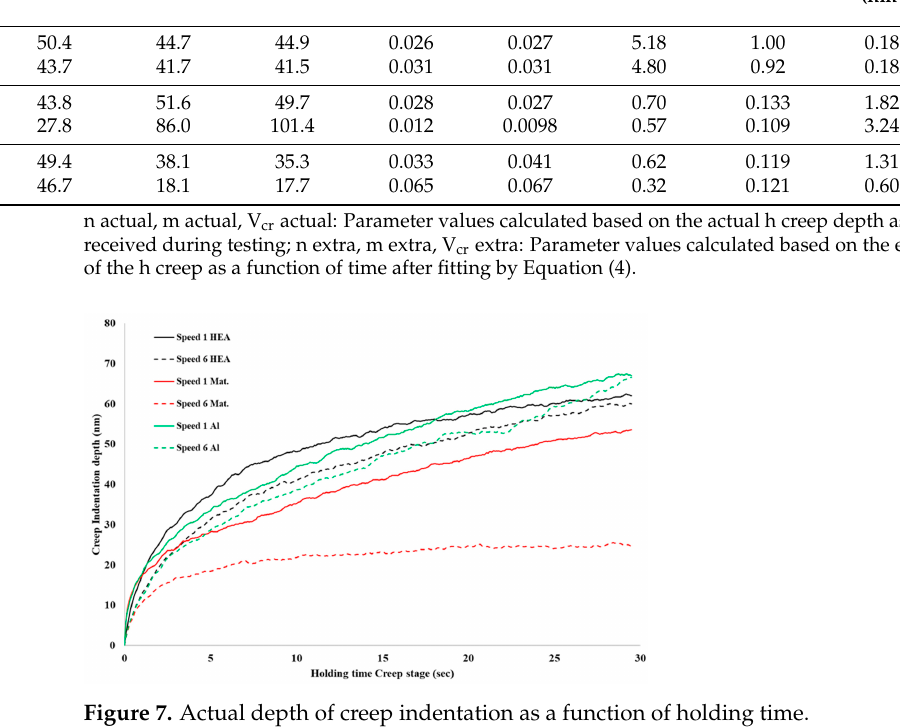
Figure 8. V cr comparison for the three areas of interest at two different creep speeds for actual and extrapolated values. As far as the actual creep depth (indicative h creep time curves are shown in Figure 7) is concerned (h creep ) it can be observed that in all case the creep depth lays roughly within the range 44–51 nm, with the only exemption being that of the matrix behavior at the low loading speed. This observation of almost the same creep depths might cause a misleading conclusion that all the different phases have the same creep behavior which is not the case as is discussed in the following paragraphs. More specifically, let us compare the RHEA reinforcing phase with pure Al. As men- tioned previously, both of them have almost the same pure creep indentation depths. The RHEA phase is a hard BCC type system, whereas pure Al is a soft FCC phase. Their net creep depth may be similar, yet the stress exponent in the case of RHEA is 44.7 for the